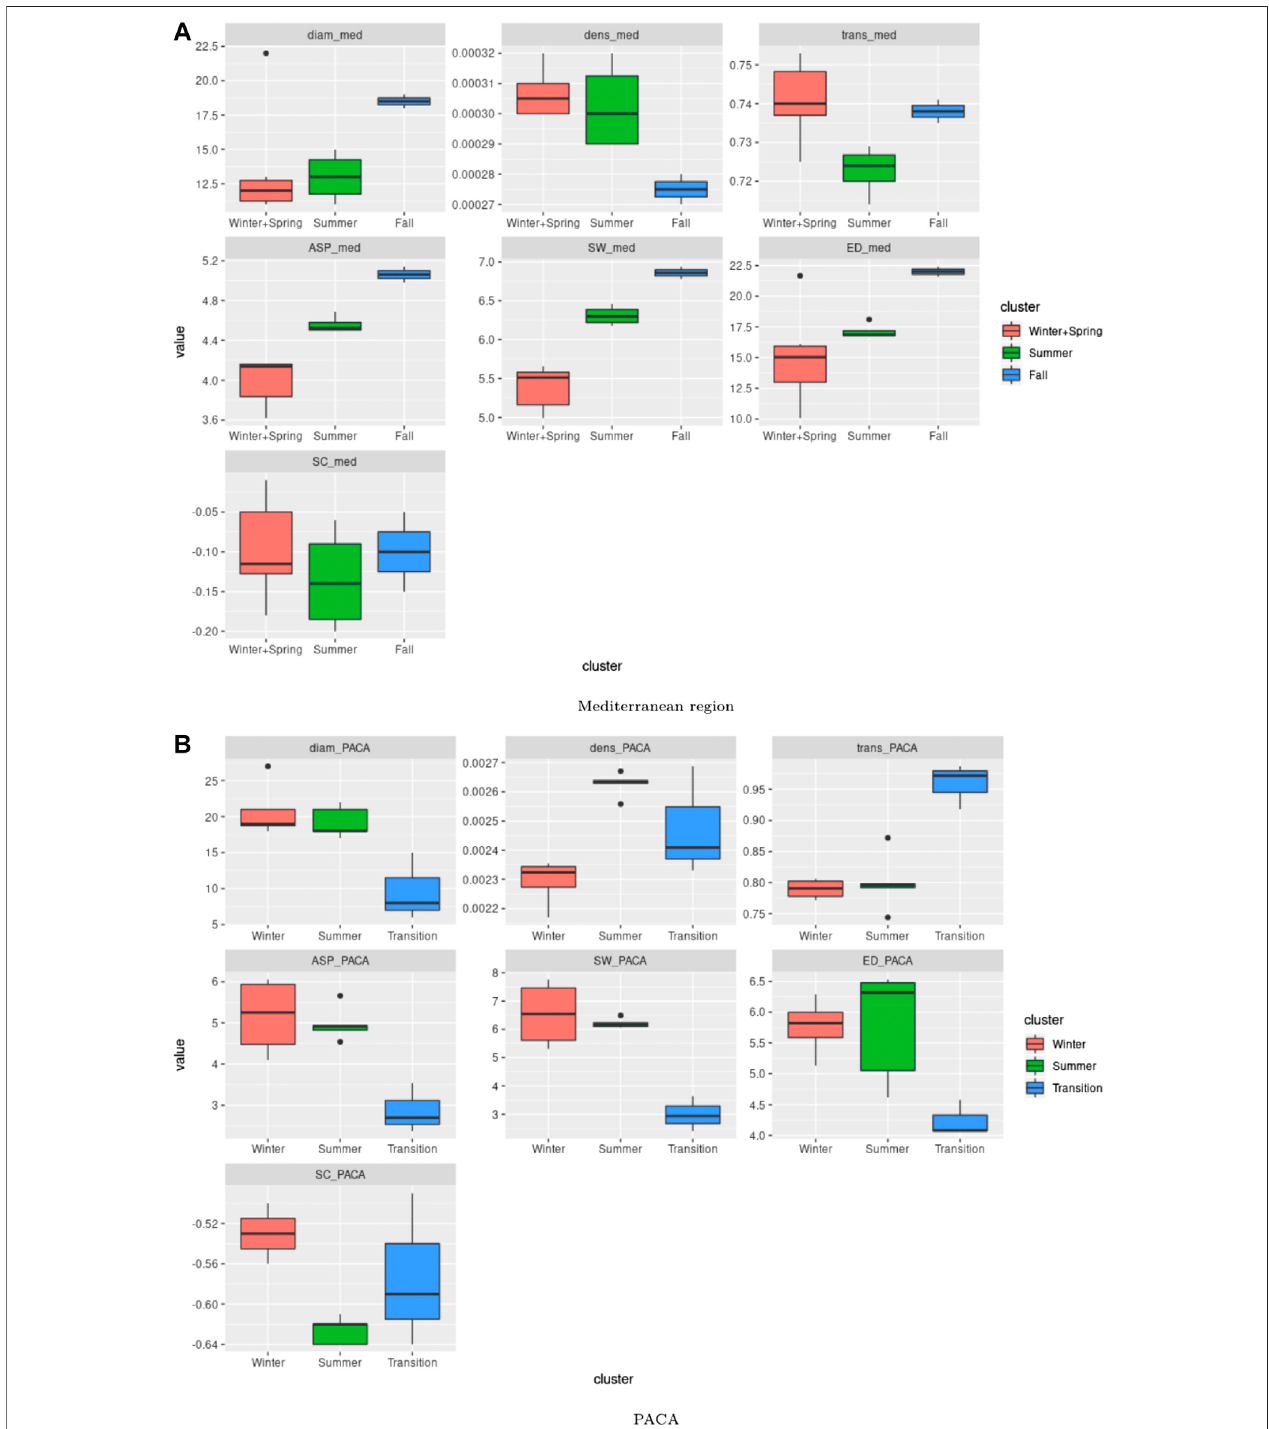
FIGURE 6 | Boxplot for the computed indices over the Mediterranean and PACA regions: Boxplot for the different indices (Diameter, density, transitivity, average shortest path, small worldness, effective distance, strength correlation) obtained from (A) the two clusters identi fi ed for the Mediterranean region (see Figure 5 ) and (B) the three clusters for PACA (see Figure 7